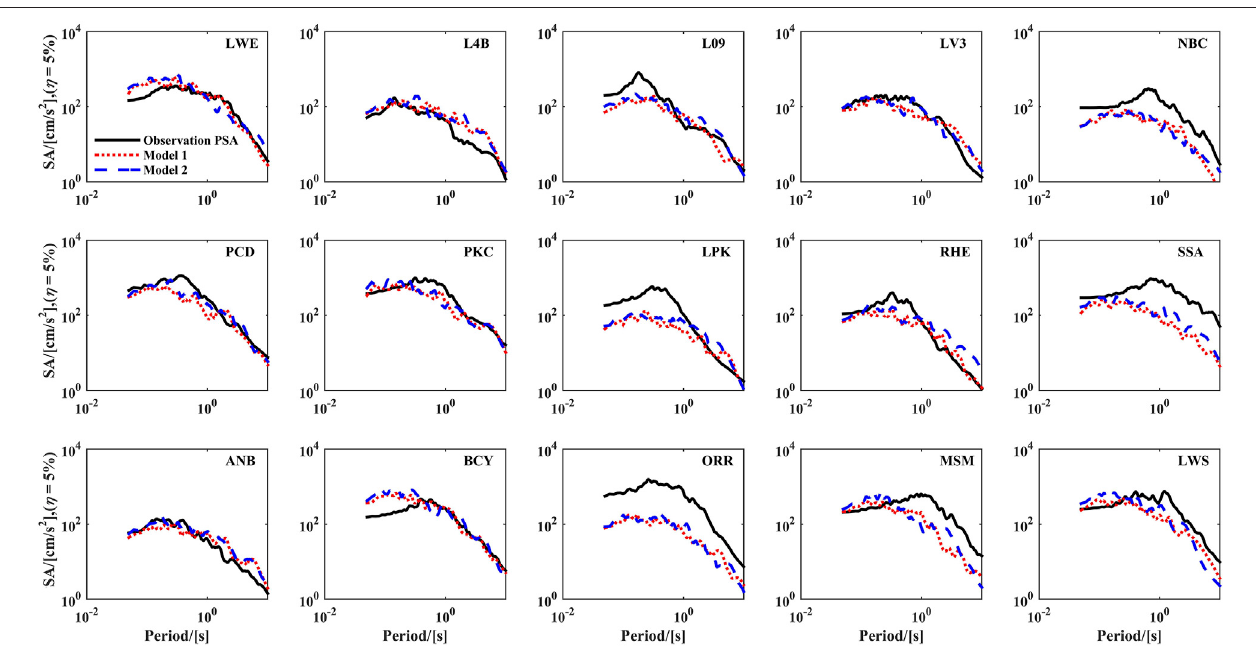
FIGURE7| ComparisonoftheobservedandthesimulatedSAforthe15selectedstationsintheNorthridgeearthquake.SimulatedSAsaretheaverageof30trials for each case. The black solid line represents the observed SA. The red dashed line and the blue double dashed line represent the simulated SA obtained by the static corner frequency (Model 1) and the dynamic corner frequency (Model 2),